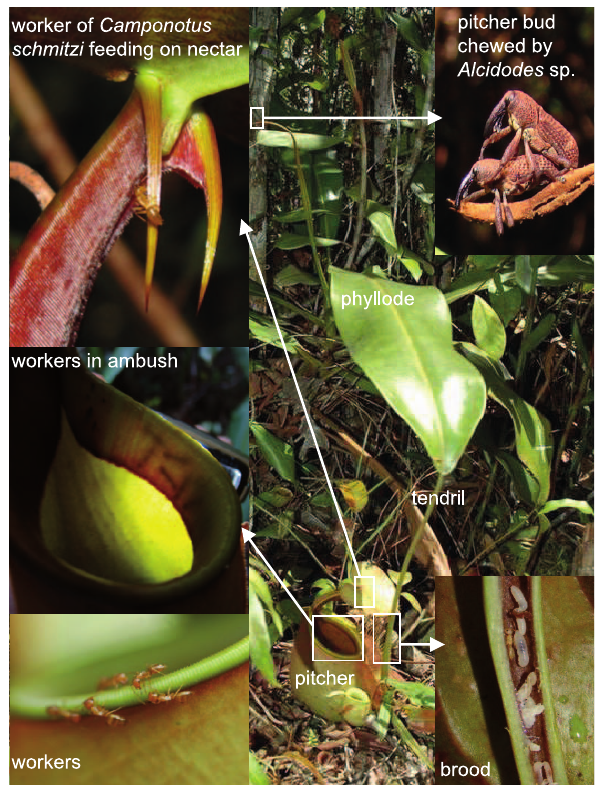
Figure 1. A juvenile Nepenthesbicalcarata showing leaf structure (photosynthetic phyllode, tendril and trap [here a lower pitcher]). The upper left inset shows a worker of Camponotus schmitzi feeding on nectar from one of the two ‘‘fangs’’ characterizing N. bicalcarata . The middle left inset shows workers of C. schmitzi in ambush beneath the peristome. The lower insets show workers (left) and brood (right) of C. schmitzi , respectively, on the peristome and in the hollow and swollen apical part of the tendril, i.e. the domatium. The upper right inset shows the Nepenthes -specific weevil, Alcidodes sp. copulating and feeding on a pitcher